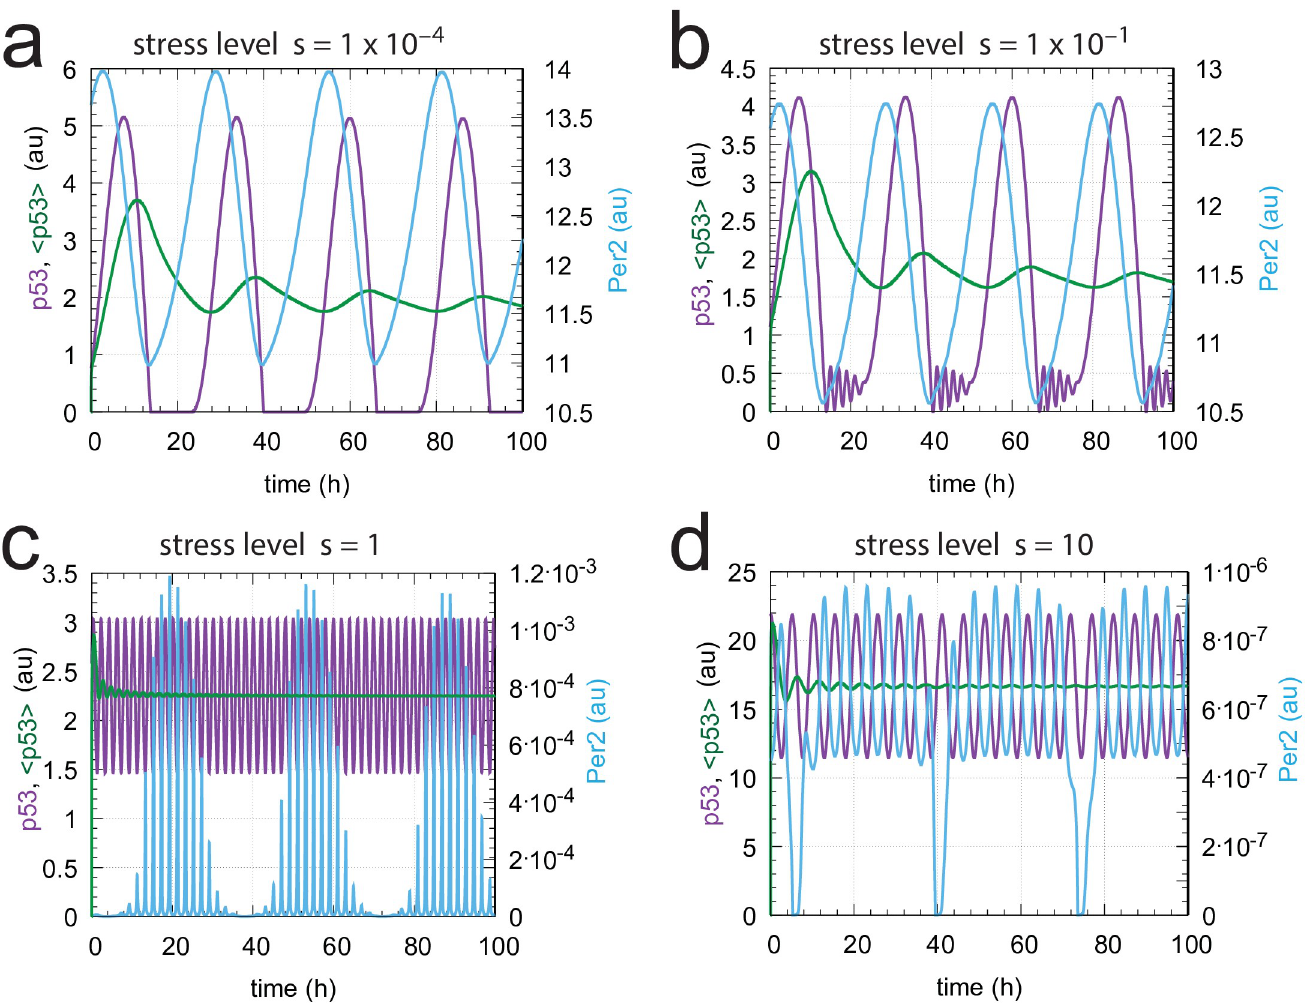
Fig 10. Steady state oscillations of p53 and Per2, together with < p53 > , at different stress levels s . Parameter values are the same as in Fig 9. (a) Oscillatory behavior when s = 1 × 10 − 4 (low stress level). Per2 determines the state of p53. Initial concentrations: p53 0 = 7.65 × 10 − 1 , Mdm2 0 = 4.82 × 10 − 8 , Per2 0 = 1.36 × 10 1 , Bmal/Clk 0 = 0.39, Per1 0 = 7.34 × 10 − 2 , (Per1 ��� Per2) 0 = 1.00, (Per1 2 ) 0 = 2.21 × 10 − 1 , (Per2 2 ) 0 = 1.86 × 10 − 1 , ATM � frequency oscillations of the ATM � controller begin to appear, but the Per2 controller still determines p53 period length. Initial concentrations: p53 0 = 1.11, Mdm2